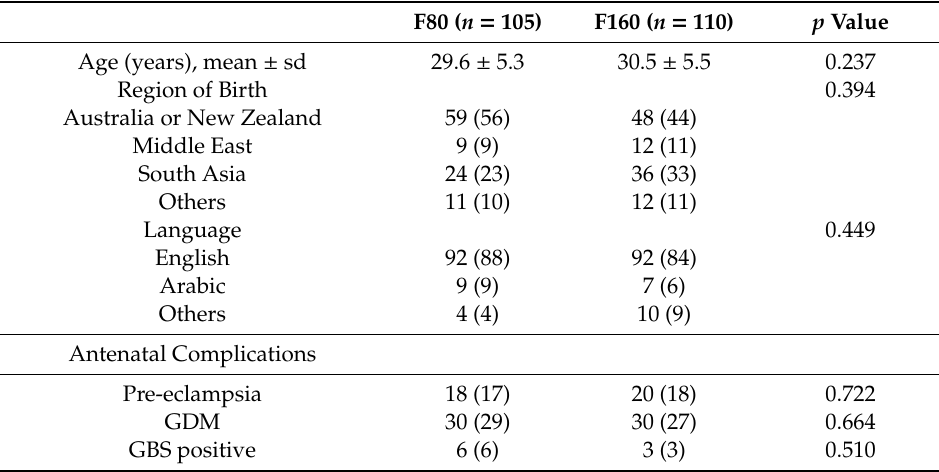
Table 2. Maternal baseline